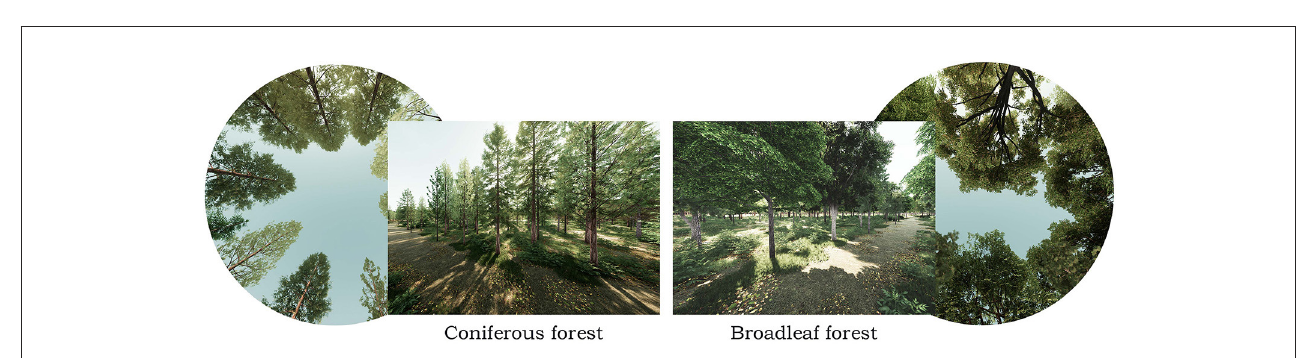
FIGURE4 Schematic screenshots of VR video used as